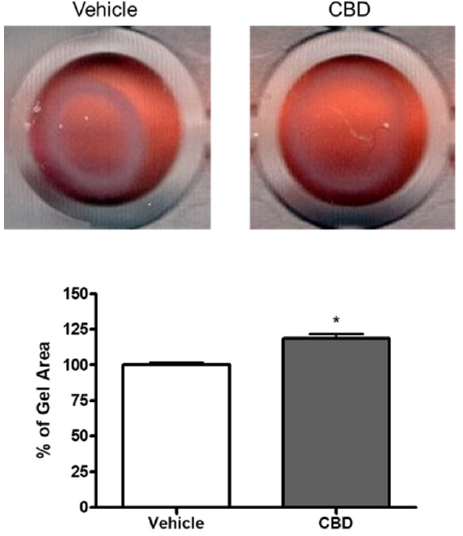
Figure 2. Effect of cannabidiol on collagen gel contraction mediated by trabecular meshwork cells. Cells grown embedded in collagen gels were treated with DMEM or DMEM containing 1 µM CBD for 48 h. Top: Representative photographs of collagen gel cultures of TM cells incubated for 48 h with the indicated drug treatment. Bottom: The mean ± SEM of results of five experiments are shown. Treatment with CBD significantly opposed the basal level of gel contraction. * Significant difference from vehicle determined by t -test, p < 0.05.